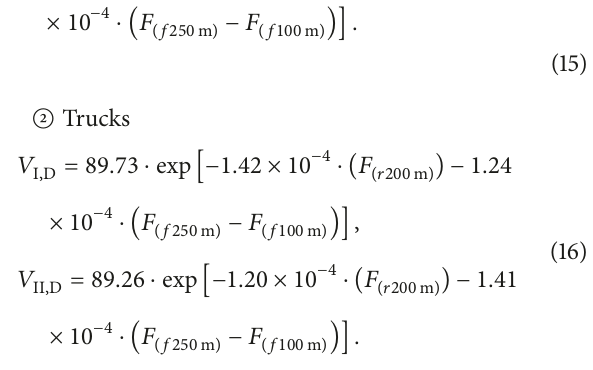
condition is good. On the contrary, the